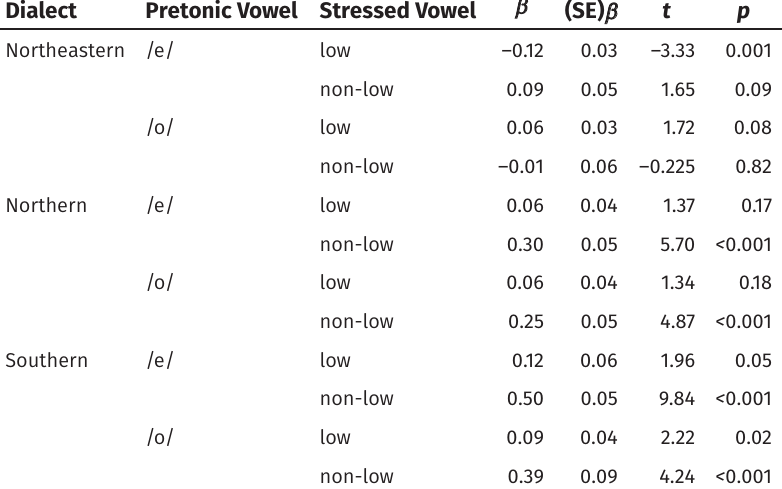
Table 6: Regression model for pretonic /e/ and /o/ followed by low and non-low stressed vowels. Each β coefficient indicates the slope of the F1-to-F1 correlation line (shown in Figures 6–8), and the associated p -value quantifies whether the slope significantly differs from